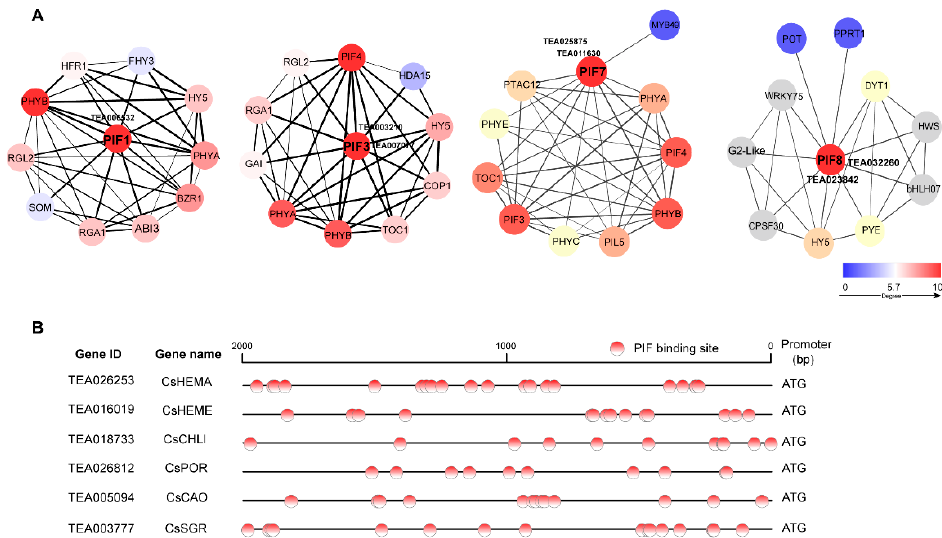
Figure 5. Analysis of protein–protein interaction networks and binding sites in promoters of CsPIF transcription factors. ( A ) Interaction networks of CsPIFs with other proteins. The thickness of the edge represents the strength of the association between two nodes. The intensity of protein interaction was represented by the color gradient, and blue to red represent low to high degree between the node and hub proteins. ( B ) DNA-binding sites of CsPIF proteins in promoter regions of structural genes in the chlorophyll metabolism pathway. The possible DNA-binding sites are marked with red point.